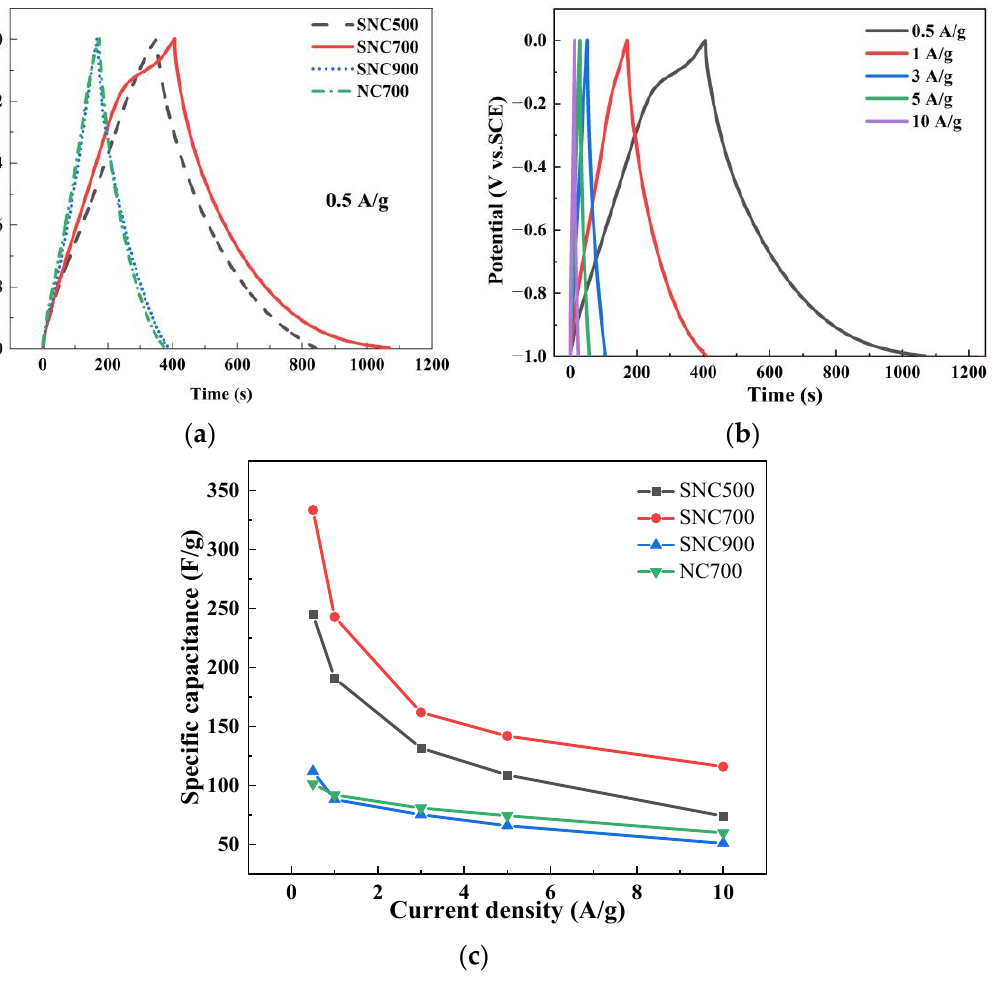
Figure 10. GCD curve of SNC material at 0.5 A/g current density ( a ); galvanostatic charge/discharge curves of SNC700 at different current densities ( b ); specific capacitance of NC and SNC materials at different current densities ( c ).